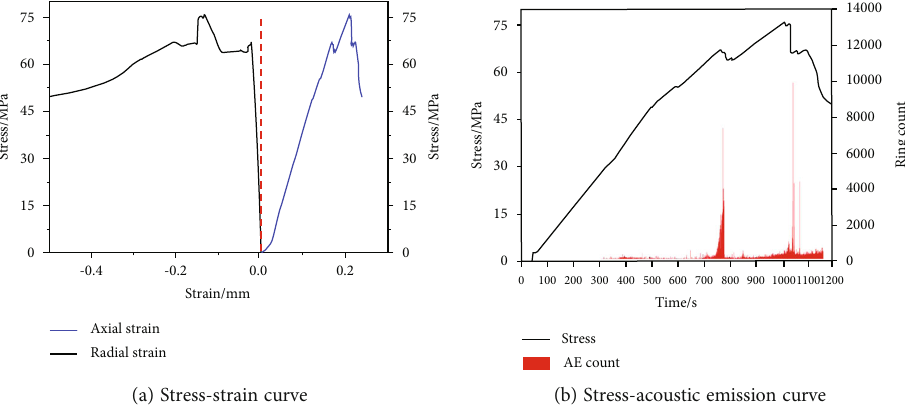
Figure 2: Rock mechanics test results of Trachyte tu ff